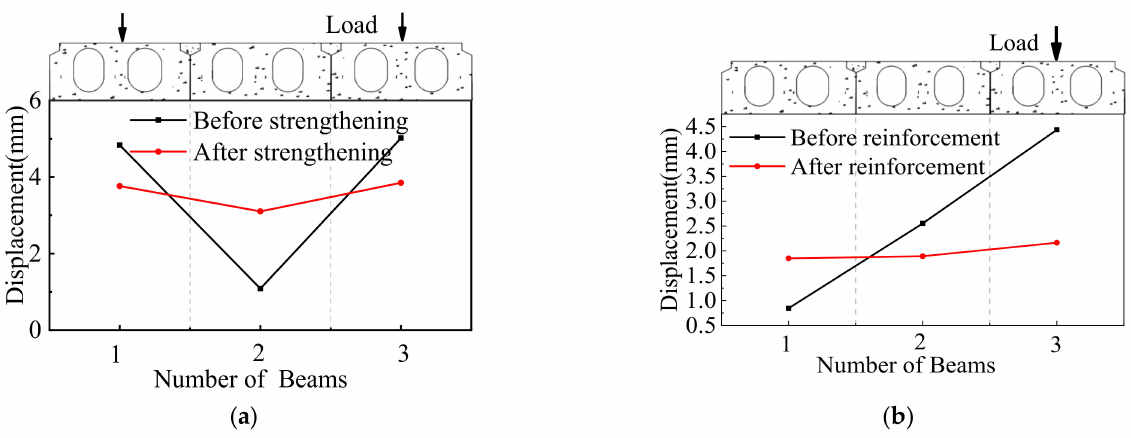
Figure 9. Displacement at the mid-span. ( a ) Symmetrical loading. ( b ) Partial